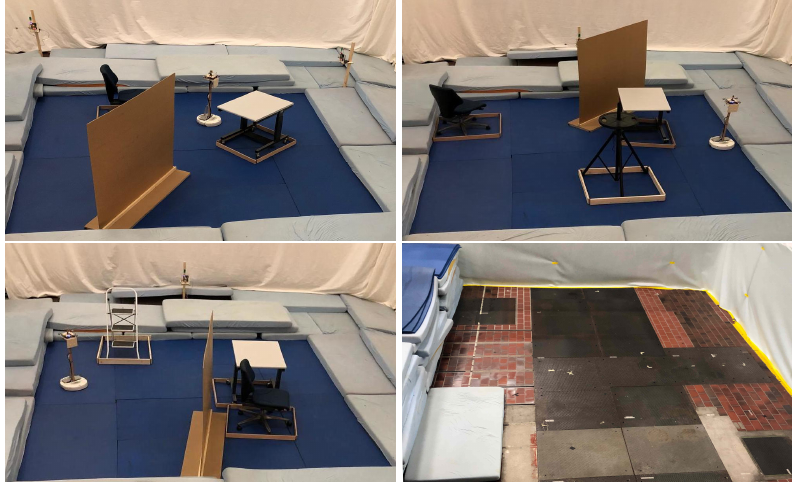
Figure 5. Three out of ten setups for data collection using the modified spline antenna are shown. In each setup the Roomba robot drove a different trajectory and the obstacles’ or the transmitters’ location was changed. The picture in the bottom right shows the floor made of ceramic tiles and metal